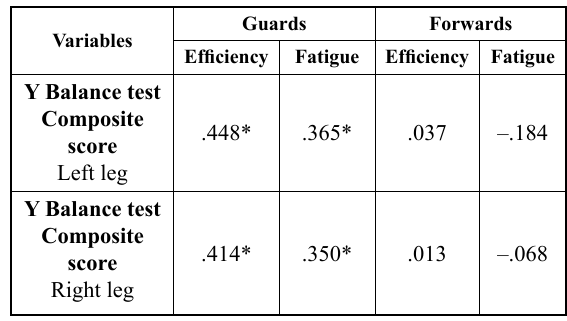
Table 3. Correlation coefficients of efficiency, fatigue, intensity and